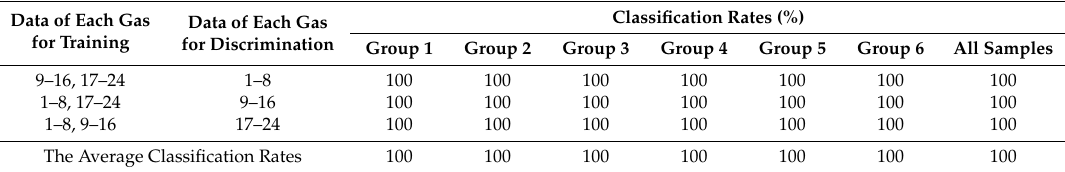
Table 3. The classification rates of FDA (Groups 1–6 represent CO, ethylene, benzene, ethanol, acetone and formaldehyde,